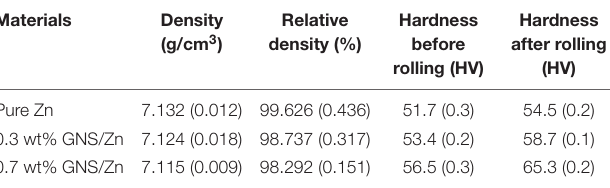
TABLE 2 | The actual density, relative density, and Vickers hardness of the materials.